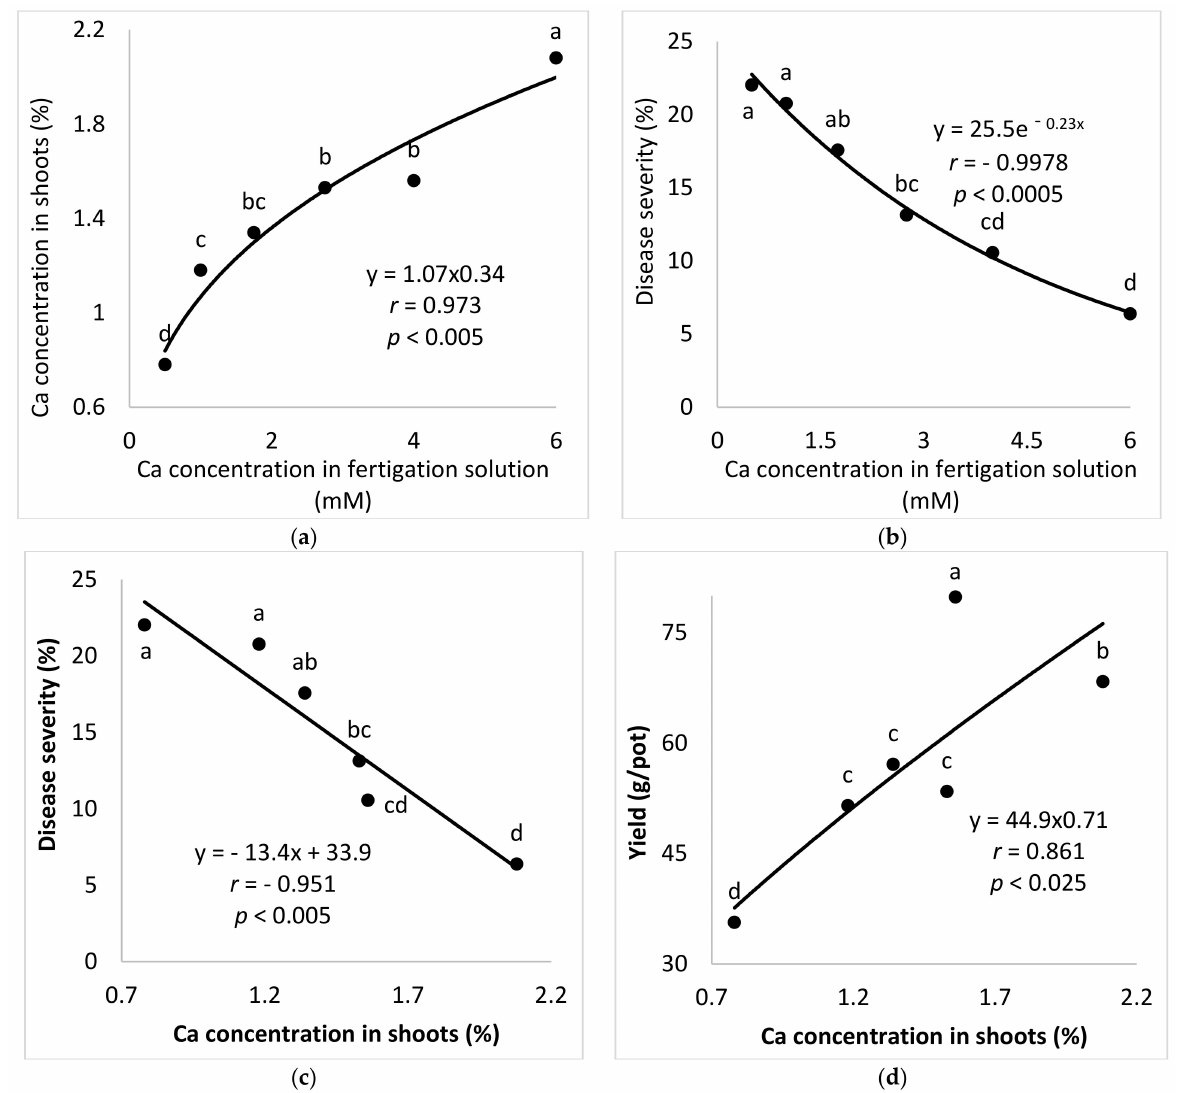
Figure 3. Effects of the Ca concentration in the fertigation solution on ( a ) the Ca concentration in the sweet basil shoots, ( b ) the severity of sweet basil downy mildew (SBDM) and ( d ) yield. SBDM severity is described in relation to the Ca concentration in ( b ) the fertigation solution and ( c ) the shoots. SBDM severity was evaluated on a 0–100% scale, in which 0 = healthy plants and 100% = plants completely covered by SBDM symptoms/signs. Data derive from 3 trials ( n = 10). In each graph, values for each Ca treatment followed by a common letter are significantly not different from each other according to Tukey–Kramer’s HSD test ( p ≤ 0.05). The correlation formulas and Pearson regression values ( r ) are presented along with significance levels ( P ). Bar =